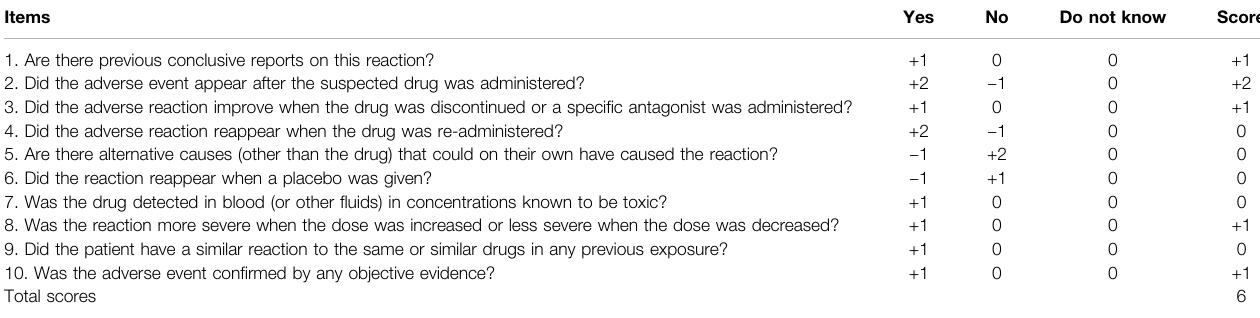
TABLE 1 | | Adverse drug reaction probability scale (Naranjo) in antiepileptic drug-related leukopenia. Items Yes No Do not know Score